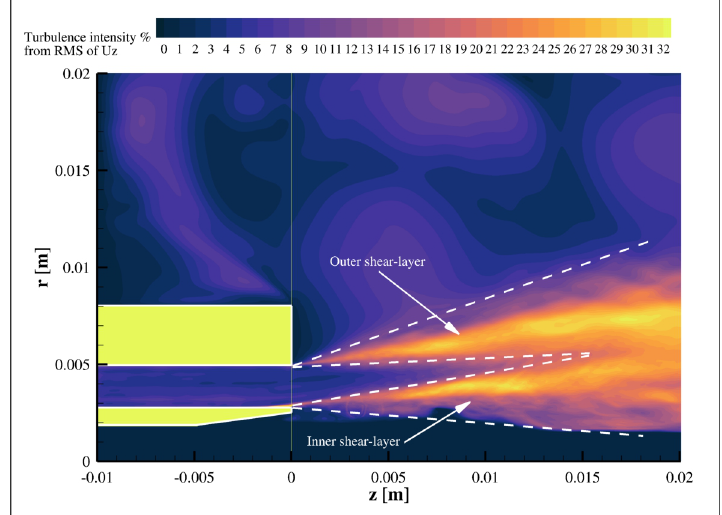
Figure 16. Turbulence intensity percentage of streamwise velocity, U z , calculated from its RMS fluctuations. Both inner and outer shear-layers are clearly